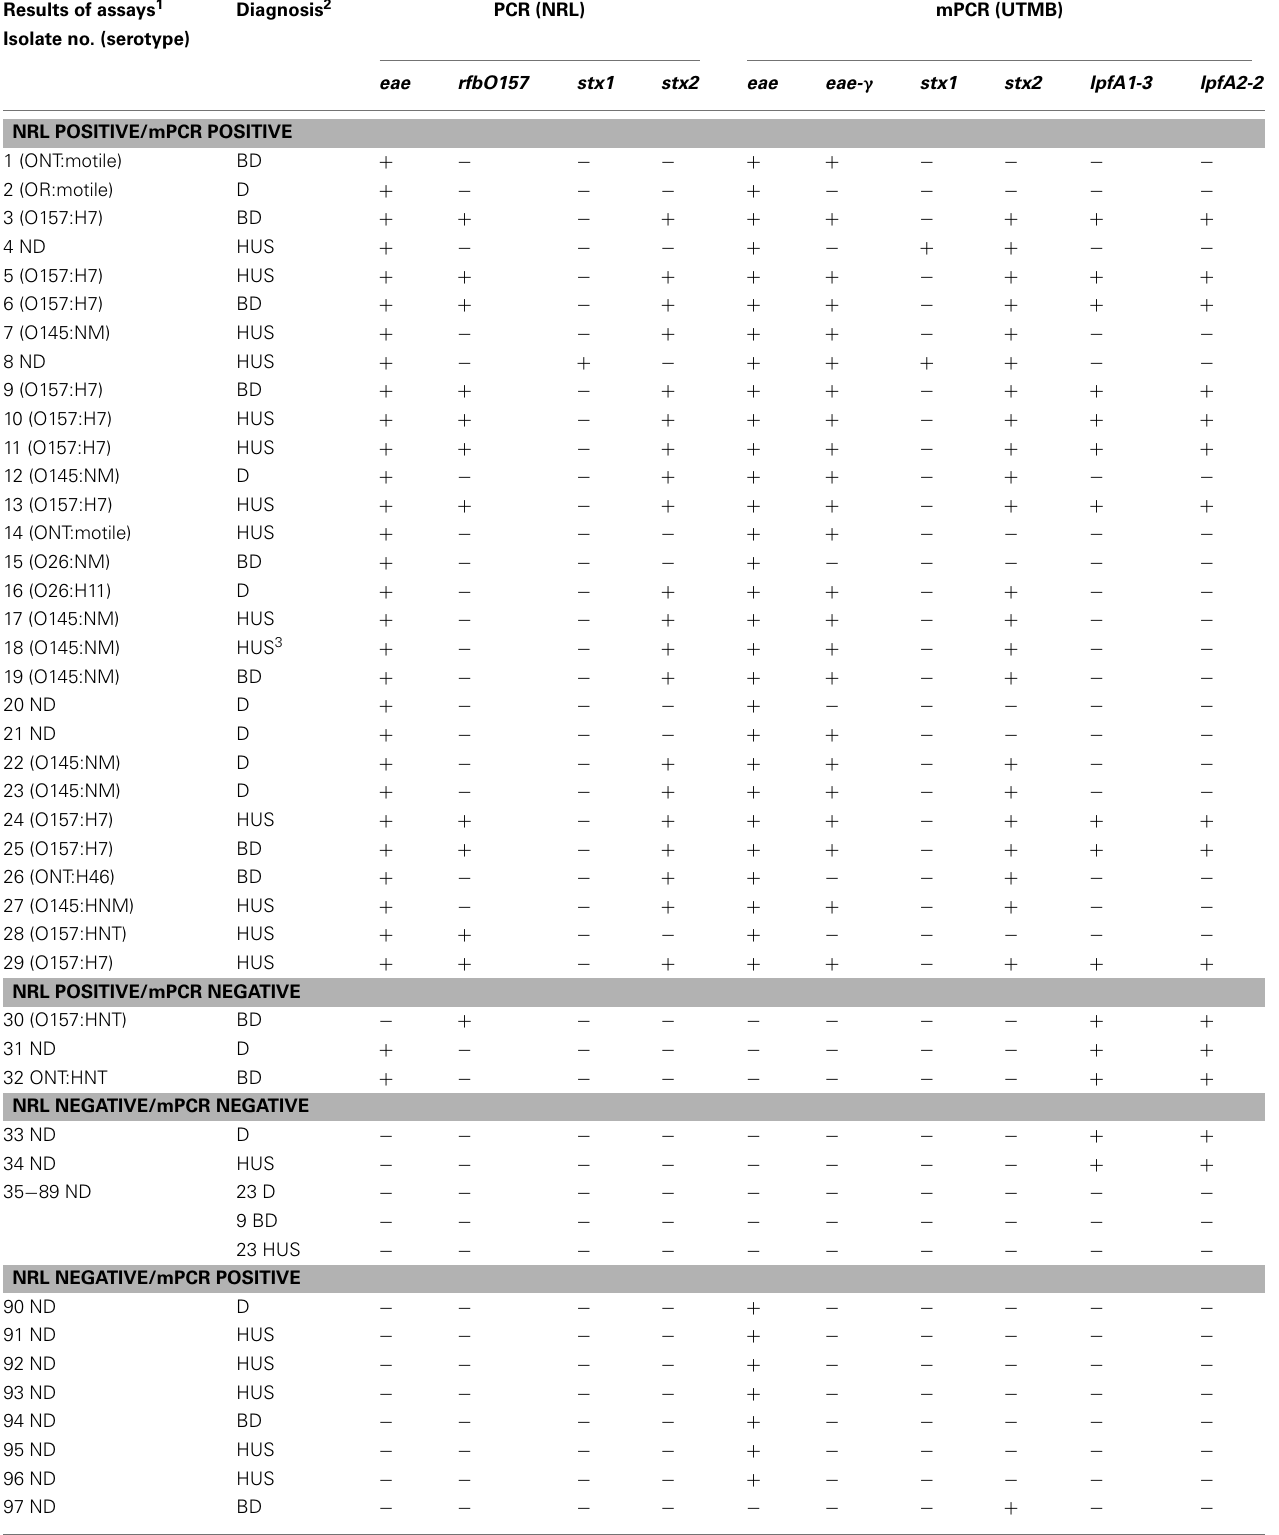
Table 3 | Comparison of results between molecular diagnostic assays at NRL and the current proposed mPCR